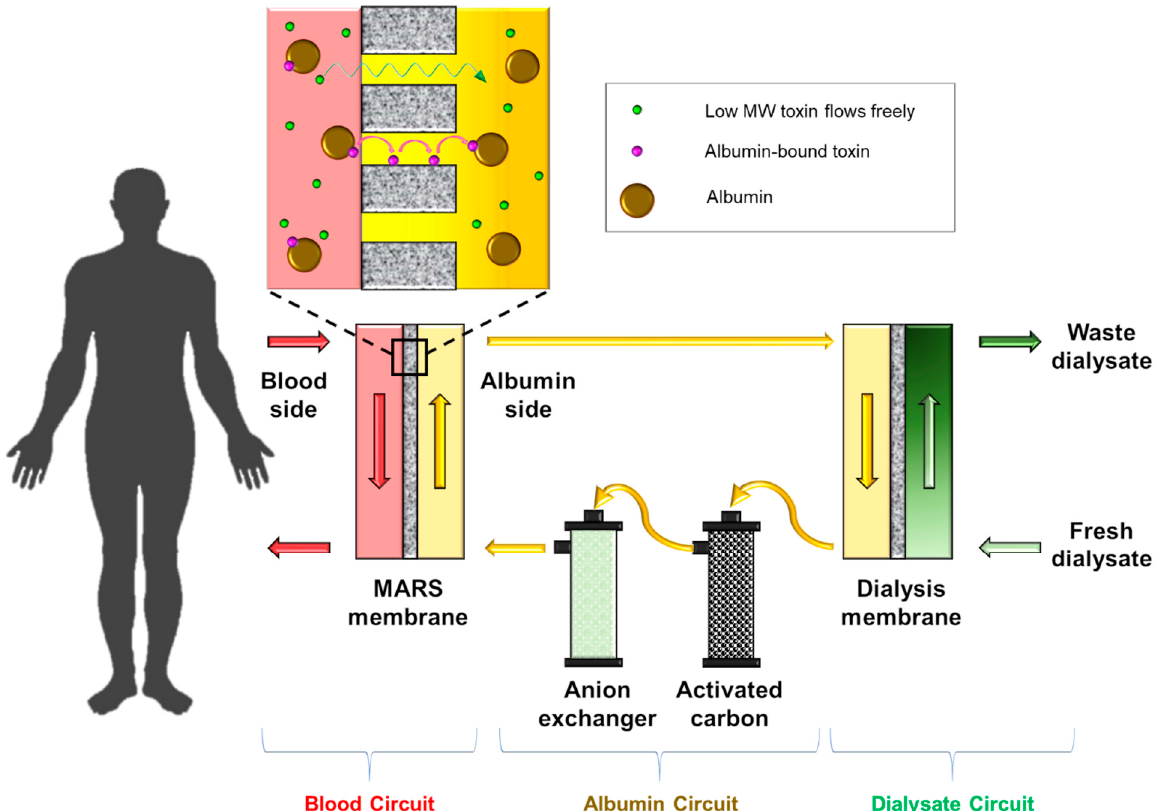
Figure 14. Simplified schematic of Molecular Adsorption Recirculating System (MARS). 190